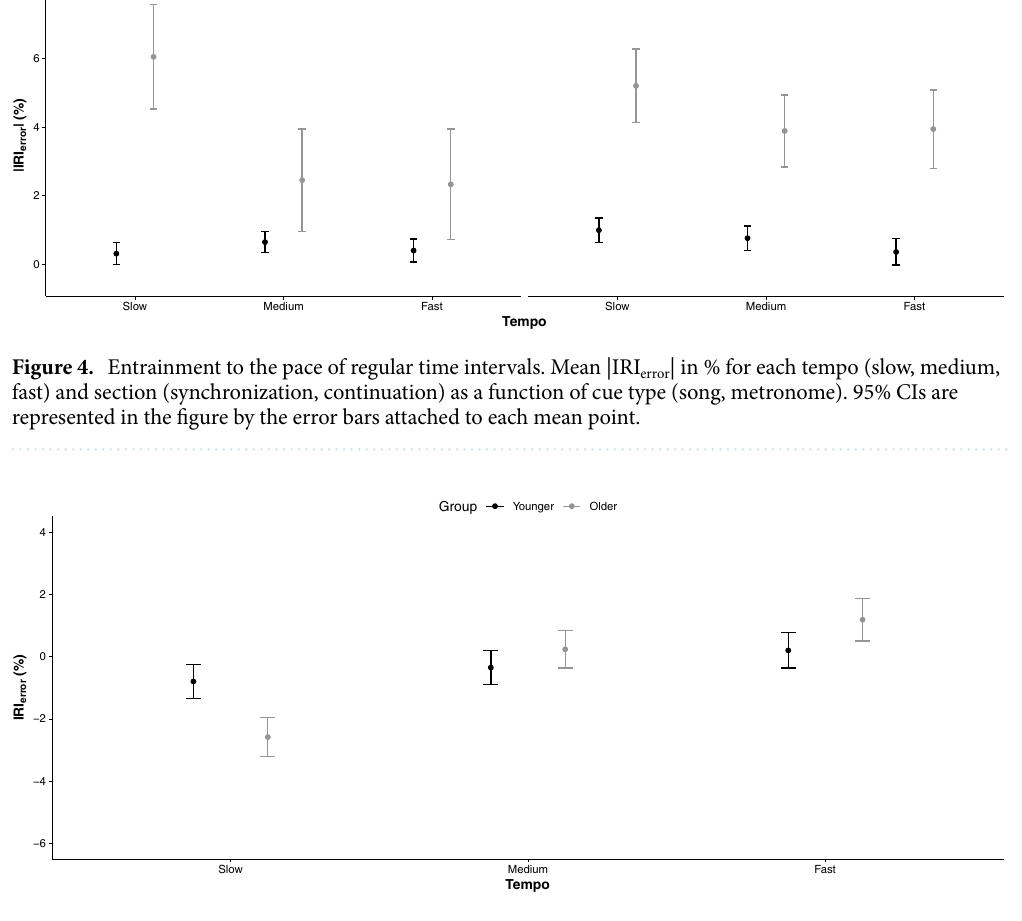
Figure 5. Signed entrainment to the pace of regular time intervals. Mean IRI error in % for each tempo (slow, medium, fast) as a function of group (younger, older). 95% CIs are represented in the figure by the error bars attached to each mean